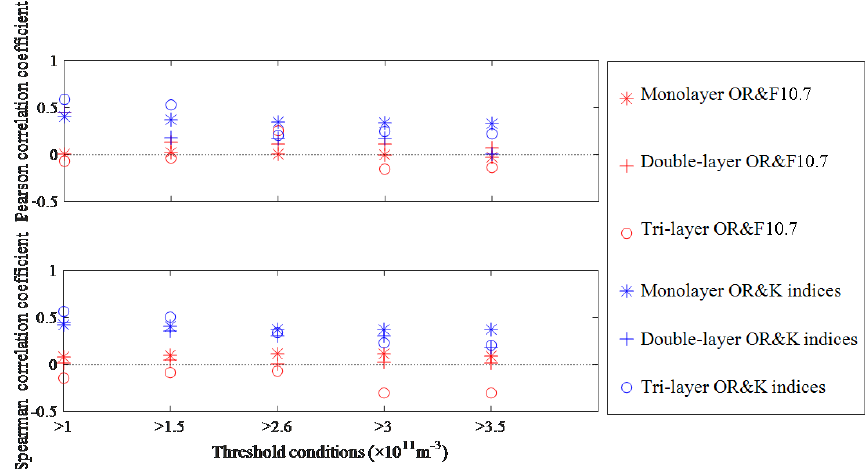
Figure 9. Pearson linear and Spearman rank correlation computed between the layered PMSE OR (with thresholds N e > 1 × 10 11 m − 3 , N e > 1 . 5 × 10 11 m − 3 , N e > 2 . 6 × 10 11 m − 3 , N e > 3 × 10 11 m − 3 , and N e > 3 . 5 × 10 11 m − 3 , respectively) and F10.7 corresponding to the occurrence of PMSEs and between the layered PMSE OR and K index corresponding to the occurrence of PMSEs, respectively. For each correlation coefficient, the P value is less than 0.05. The horizontal dotted line is drawn to separate positive and negative correlation coeffi-